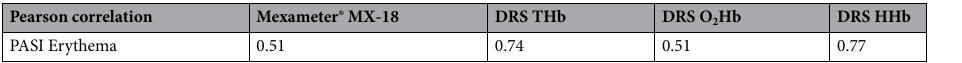
Table 3. The Pearson correlation coefficients between PASI erythema scores and the values obtained from the Mexameter and DRS measurements upon 15 patients diagnosed with psoriasis vulgaris.